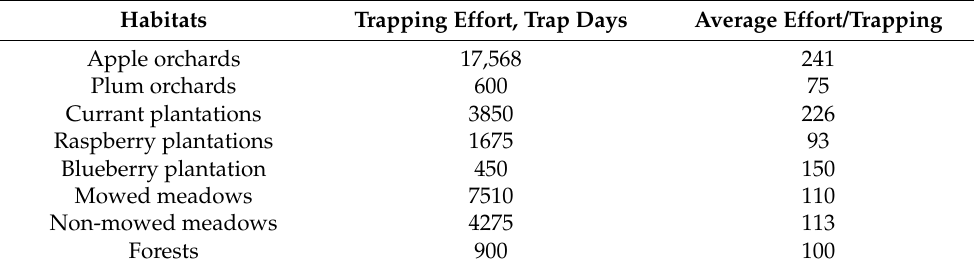
Table A2. Trapping effort in orchards, plantations, and their control habitats, 2018–2022.